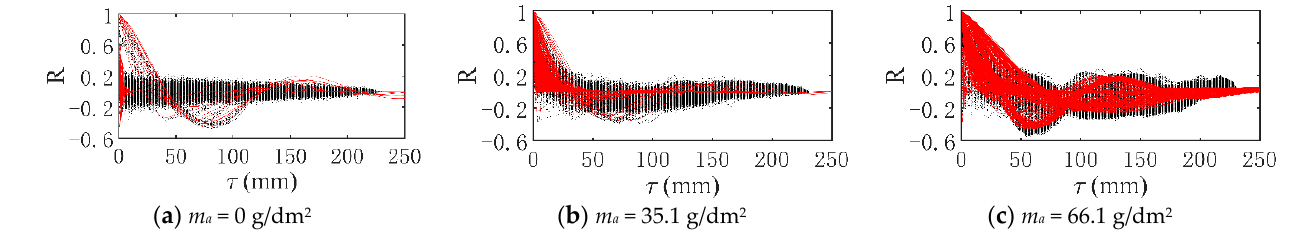
Figure 12. Sample autocorrelation function fitting diagram.